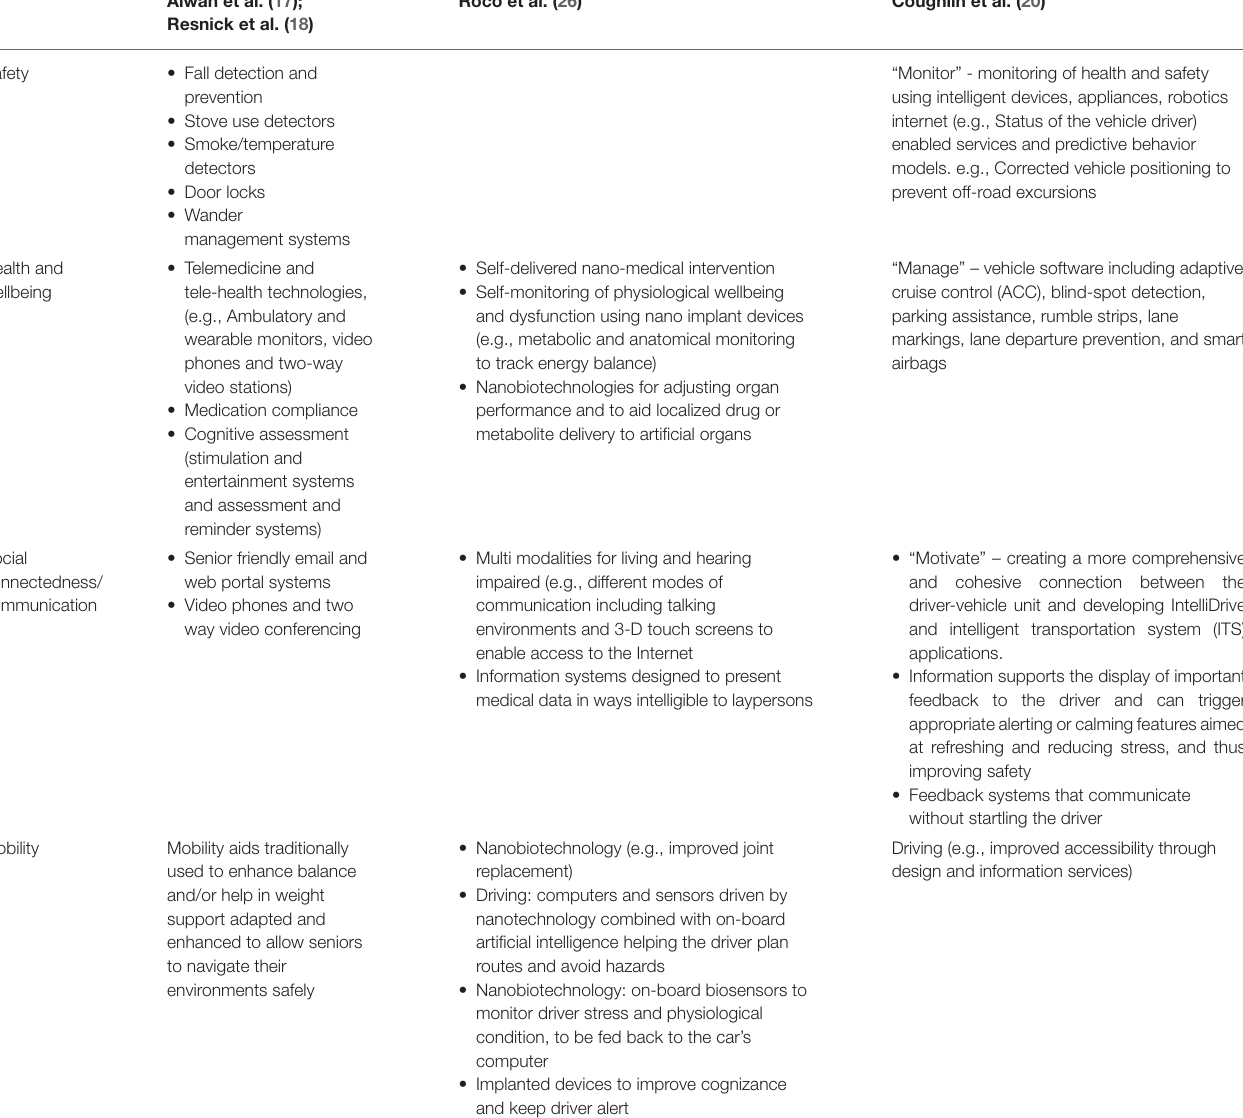
TABLE 1 | Selected technological frameworks relevant to maintaining the health and wellbeing of older Women’s